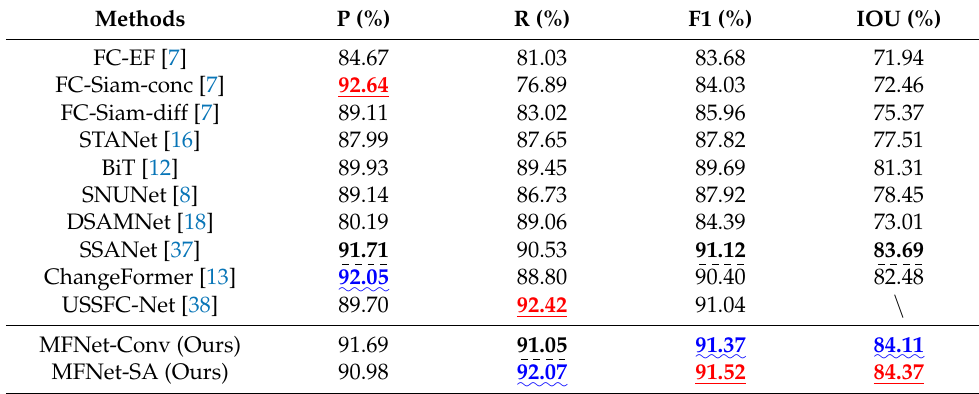
Table 4. Quantitative evaluation results of different algorithms on